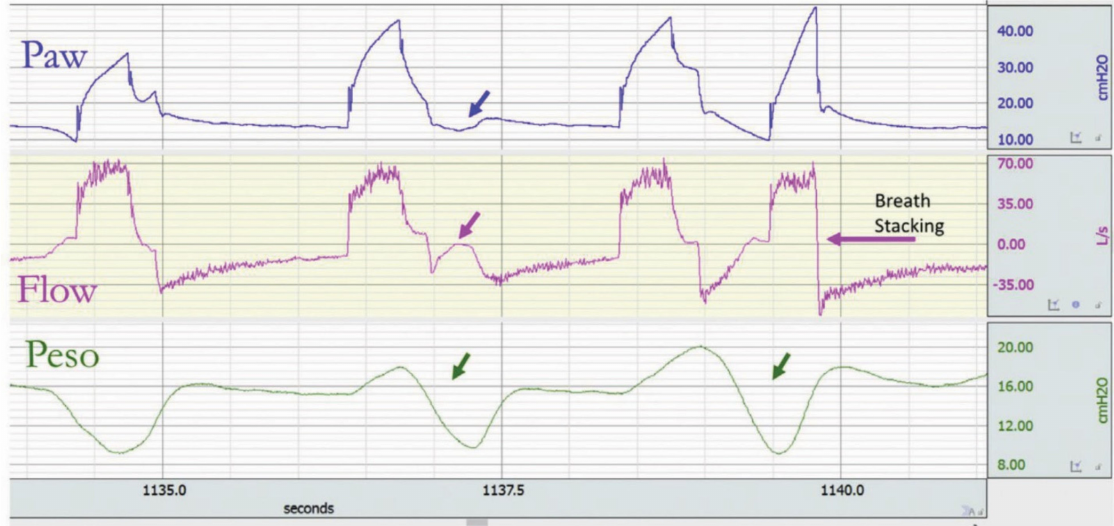
Figure 7. Reverse triggering and breath stacking in volume assist–control. The first breath is patient-triggered; the second is triggered by the ventilator and followed by a reverse triggering (first green arrow) starting in the late phase of ventilator insufflation and continuing during the early phase of ventilator exsufflation leading to a positive deflection of the flow (pink arrow) not triggering a new breath; and the third breath is ventilator-triggered, followed by a reverse triggering (second green arrow). This reverse triggering leads to a fourth breath before complete exhalation of the previous one (breath stacking). Reprinted with permission from